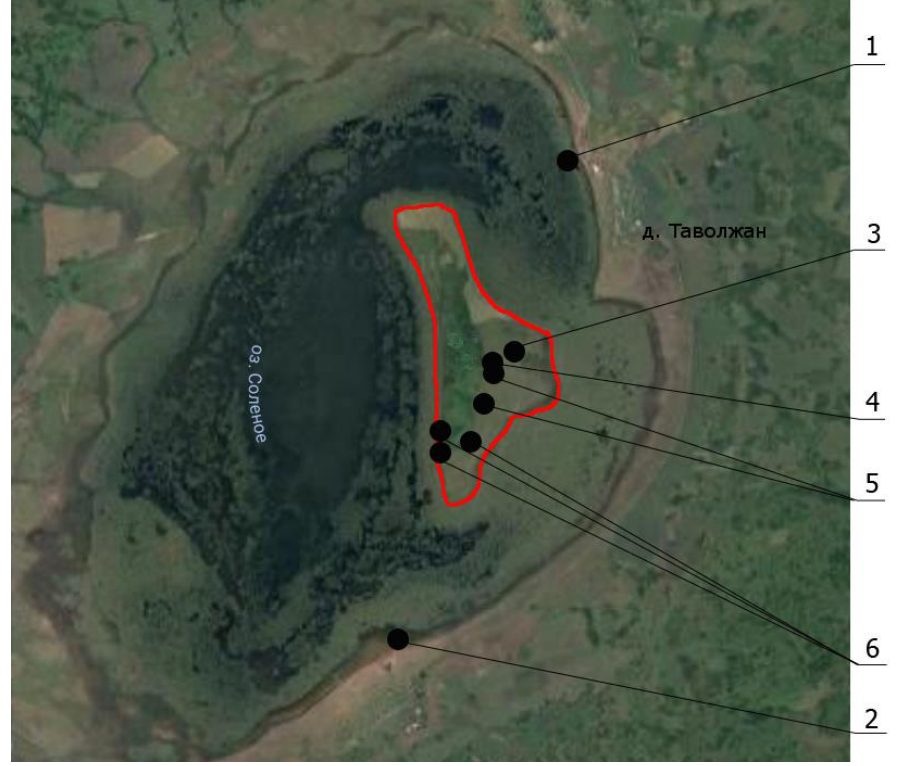
Рис. 3. Местонахождения некоторых охраняемых в Тюменской области видов растений на исследованной территории. Цифрами обозначены: 1 – Zannichellia repens, 2 – Zannichellia pedunculata, 3 – Scorzonera parviflora, Fig. 3. Locations of some plant species protected in the Tyumen Region in the studied area. The numbers denote: 1 – Zannichellia repens, 2 – Zannichellia pedunculata, 3 – Scorzonera parviflora, 4 – Stipa pennata, 5 – Peucedanum morisonii, 6 – Pedicularis